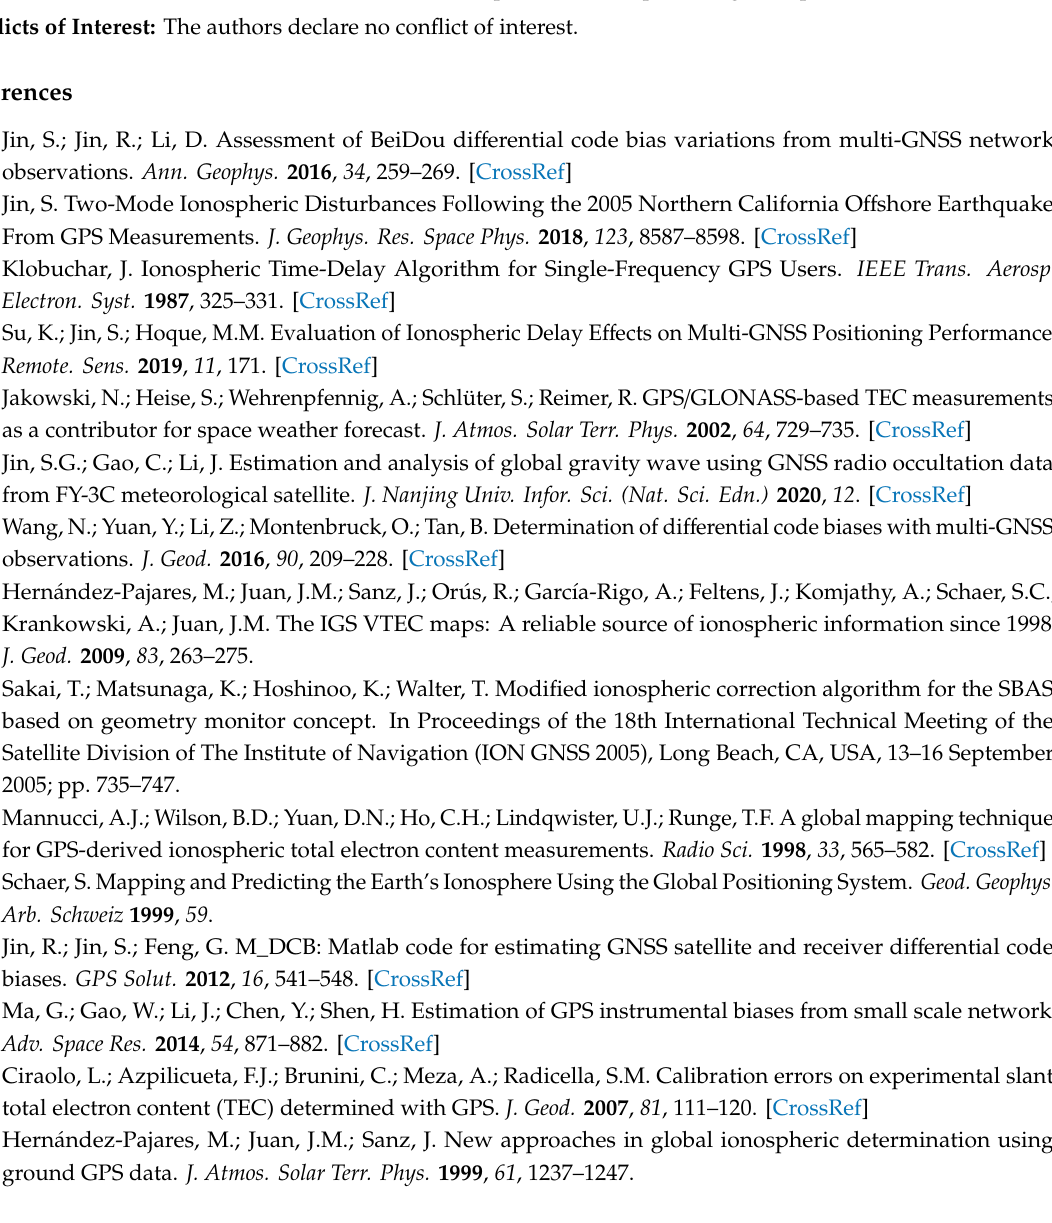
Figure S1: Successive daily changes of geographic distribution of reference stations (shown in green dot) and discarded stations (shown in red dot) during 15th to 30th in January